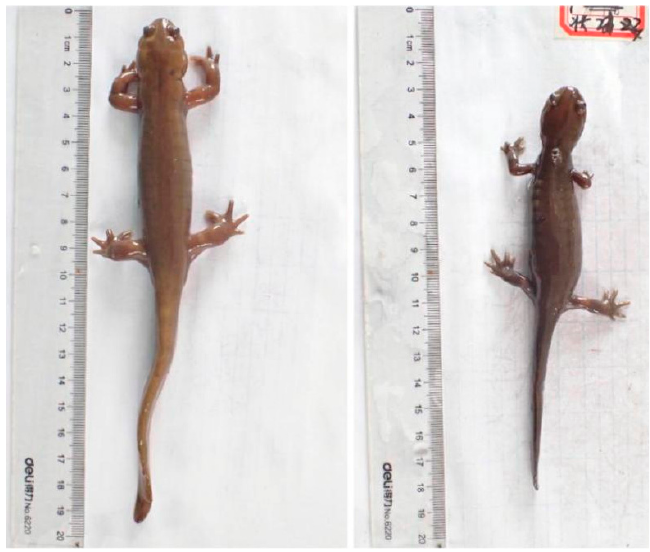
Figure 2. Sexual dimorphism in Hynobius maoershanensis . Overall view. Male ( left ) and female ( right ).